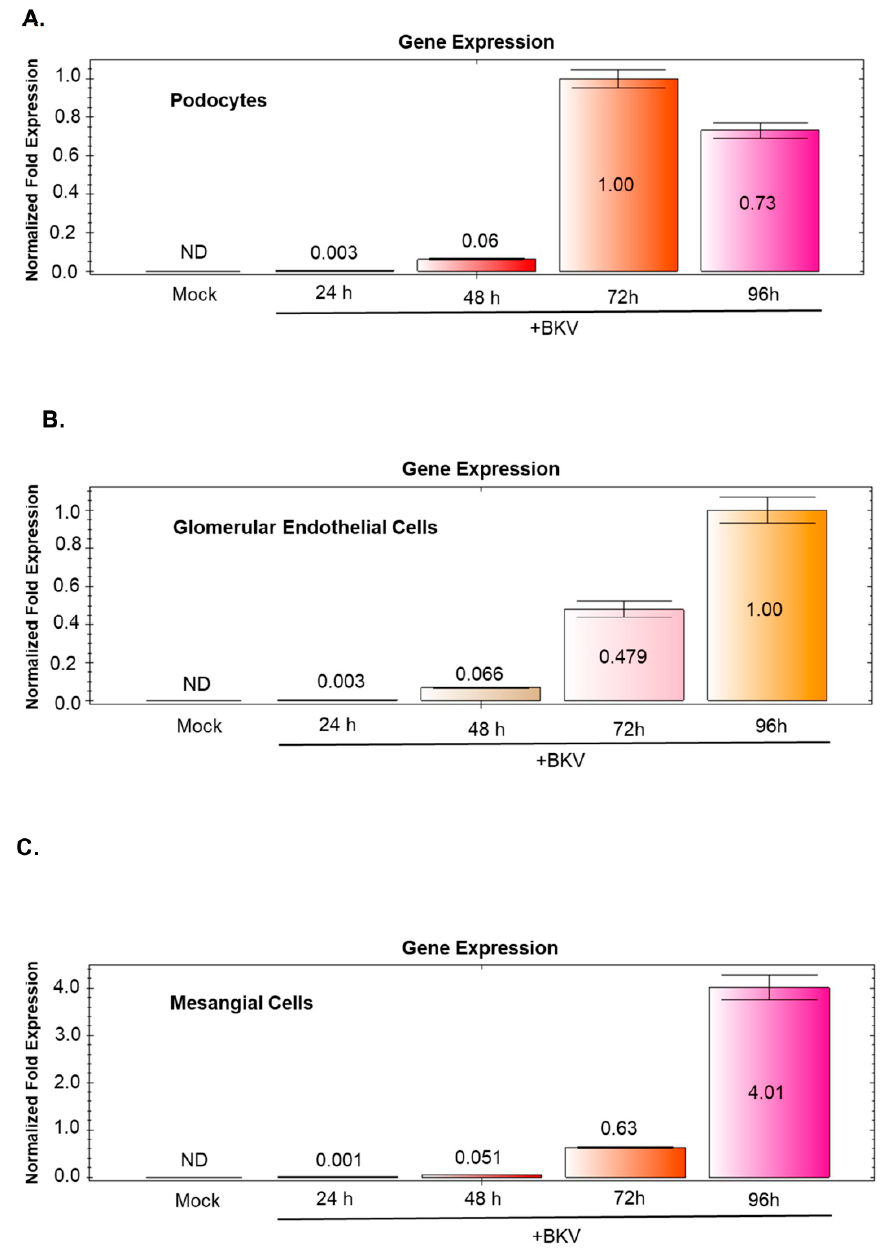
Figure 7. Time course analysis of VP1 expression in BKV-Infected GVU cells. ( A ) qRT-PCR analysis of mock-infected undifferentiated podocytes and podocytes infected with BKV for 24, 48, 72, and 96 h. ( B ) qRT-PCR analysis of mock-infected glomerular endothelial cells and glomerular endothelial cells infected with BKV for 24, 48, 72, and 96 h. ( C ) qRT-PCR analysis of mock-infected mesangial cells and mesangial cells infected with BKV for 24, 48, 72, and 96 h. PCR results were normalized to GAPDH.